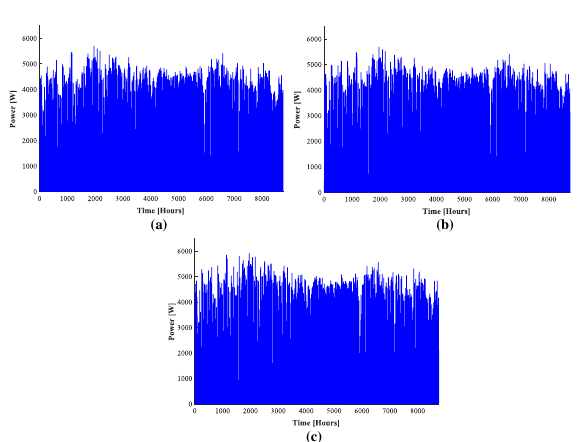
Fig. 15 Annual generated power using different MPPT techniques on SM55 PV array a P&O MPPT, b IC MPPT,